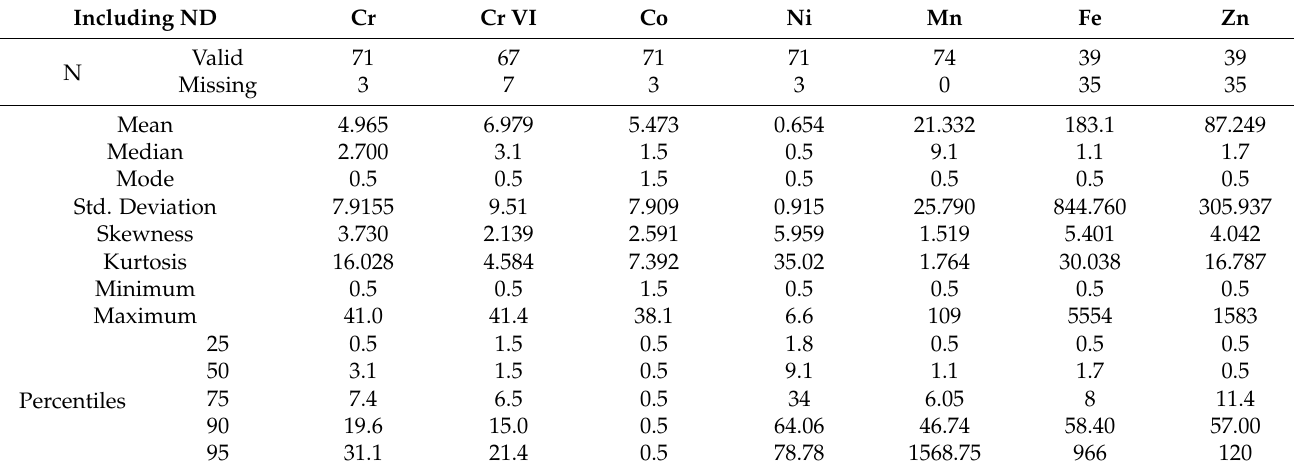
Table 4. Descriptive statistics of the total number of PTE measurements (in µ g/L) (Table S3), including ND. Including ND